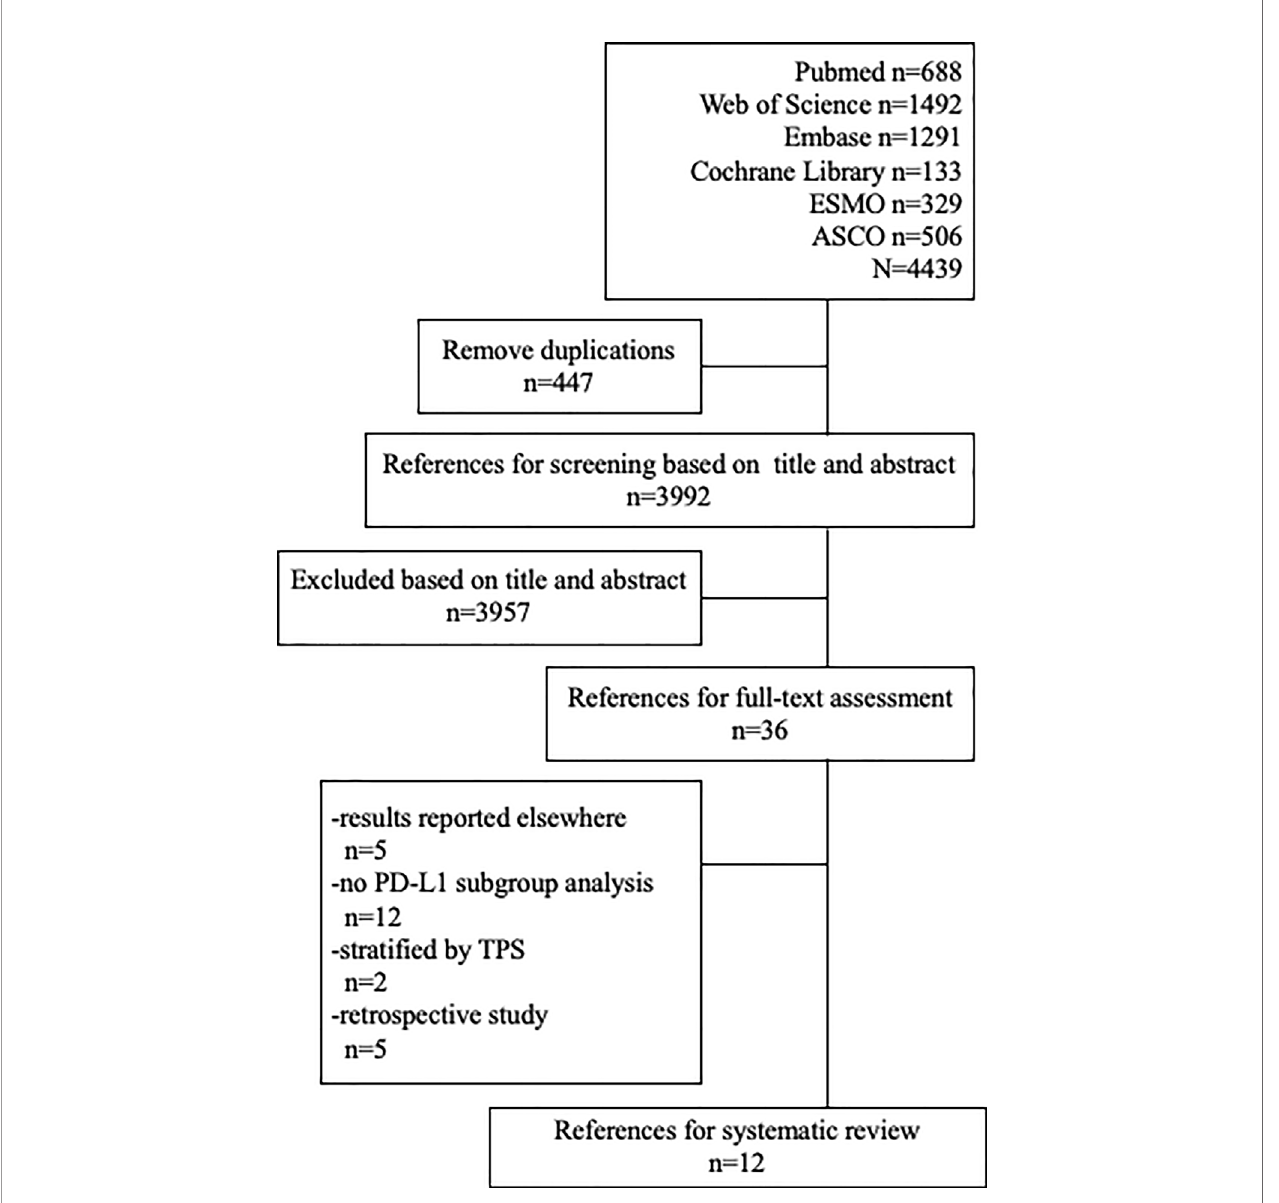
FIGURE 1 | The diagram of searching